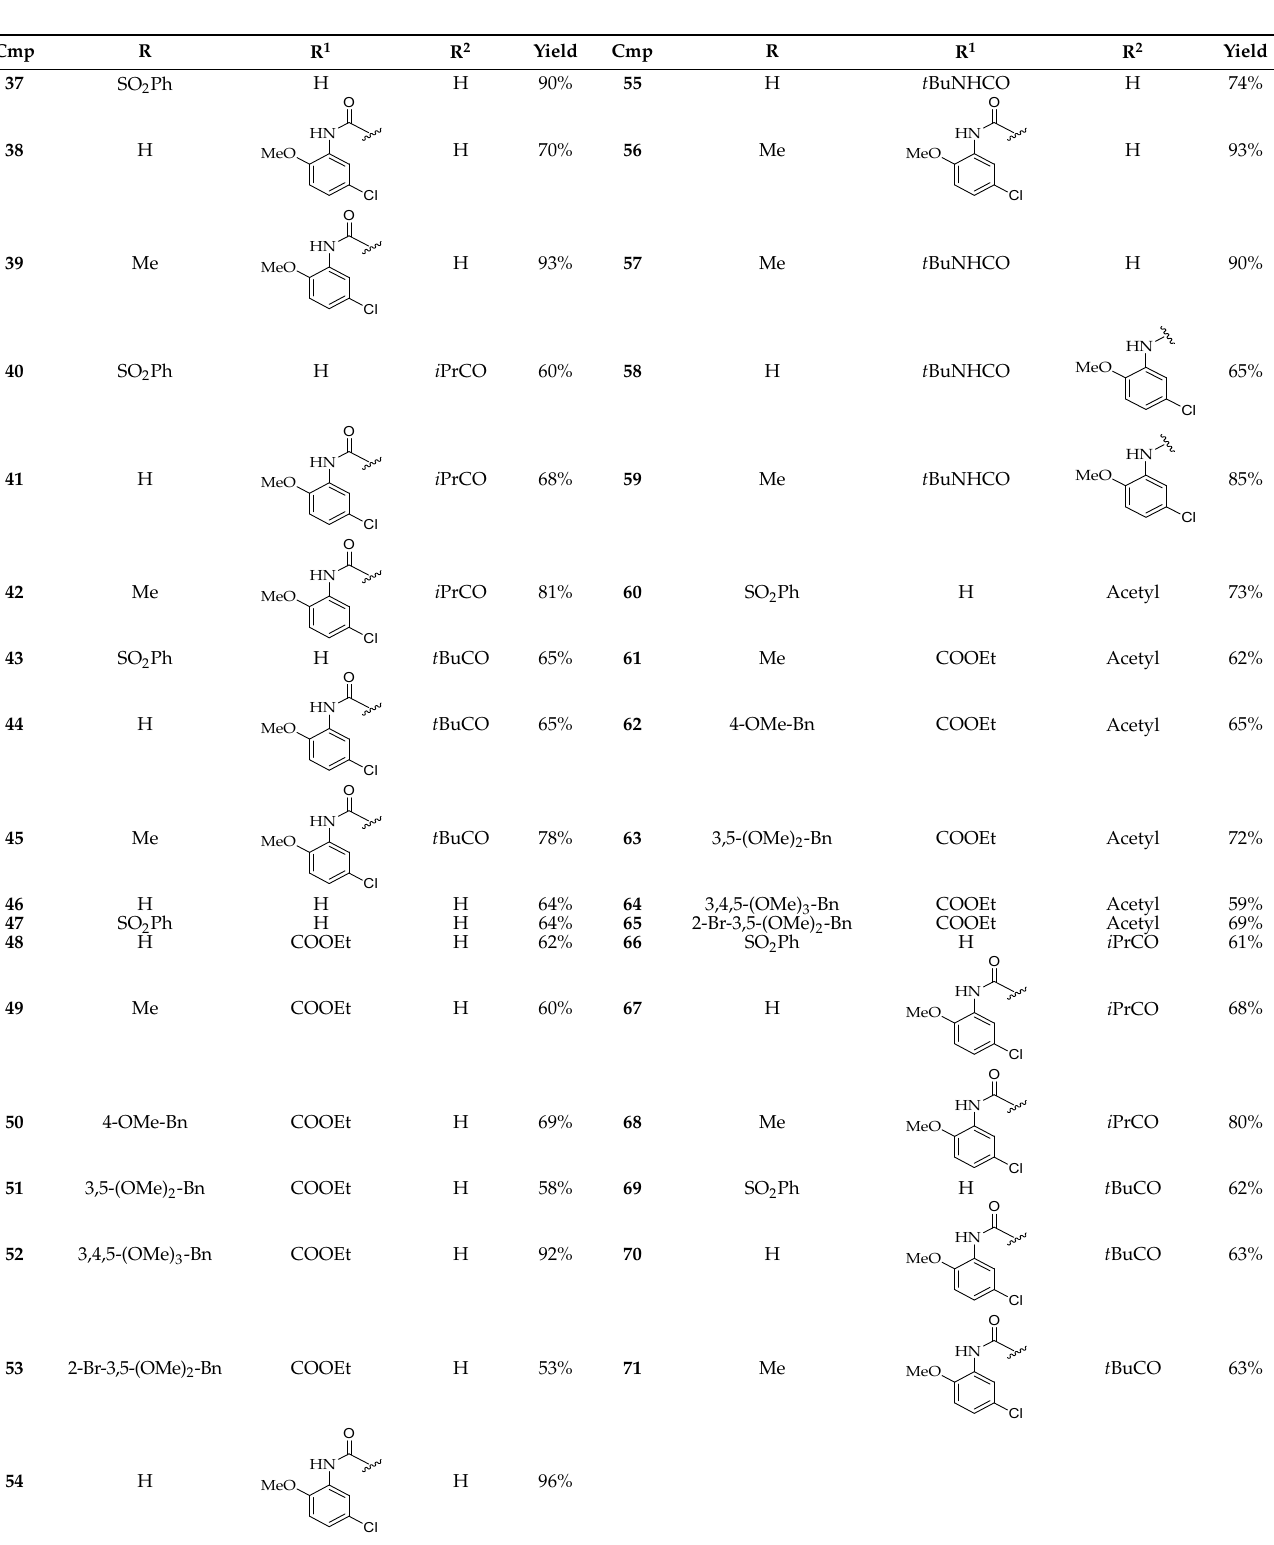
Table 2. [1,3]Thiazolo[5,4 ‐ g ]indole ‐ 2 ‐ amines 37 – 45 and pyrrolo[3’,2’:6,7]cyclohepta[1,2 ‐ d ][1,3]thiazol ‐ 2 ‐ amines 46 – 71 .